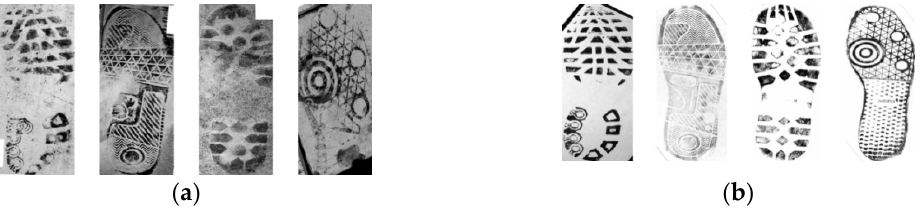
Figure 4. Examples of the probe shoeprints and their corresponding reference shoeprints in FID-300 dataset. ( a ) The probe shoeprints from crime scenes. ( b ) Corresponding shoeprints of the probe shoeprints in the gallery set.